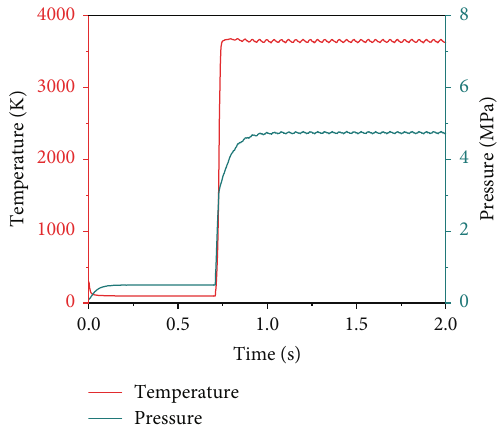
Figure 11: The start-up process in variable thrust